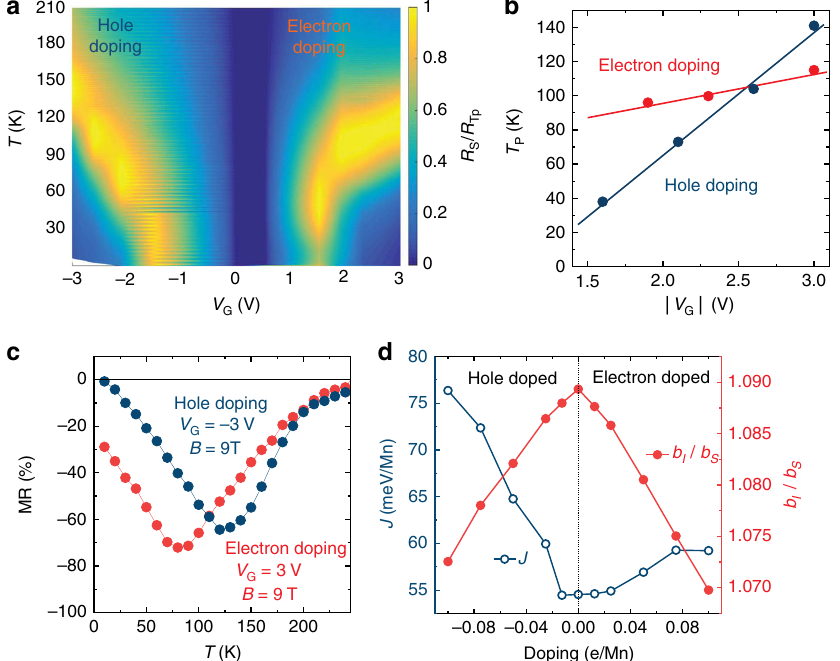
Fig. 4 Electron – hole asymmetry in electrostatically gated LaMnO 3 . a Contour plot of sheet resistance ( R S ) as a function of gate voltage ( V G ) and temperature. b Evolution of the resistivity peak ( T P ) of R S in the electron-doped and hole-doped regimes. c Asymmetric peak magnitude and temperature of the magnetoresistance (MR), de fi ned as ( R ( H ) − R (0))/ R (0)) (%), for an electron-doped or hole-doped LaMnO 3 fi lm. d First-principles calculations on the magnetism of LaMnO 3 under bipolar gating. The exchange coupling parameter and J (open blue dots) and the distortion parameter b l / b s ( fi lled red dots) are shown as a function of